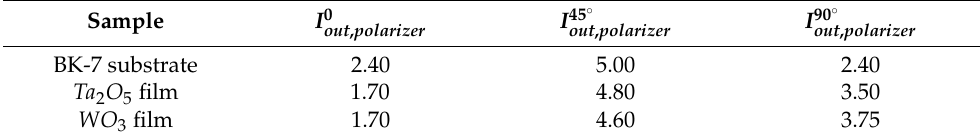
Table 1. Output light intensities with BK-7 and single-layer samples placed in the proposed